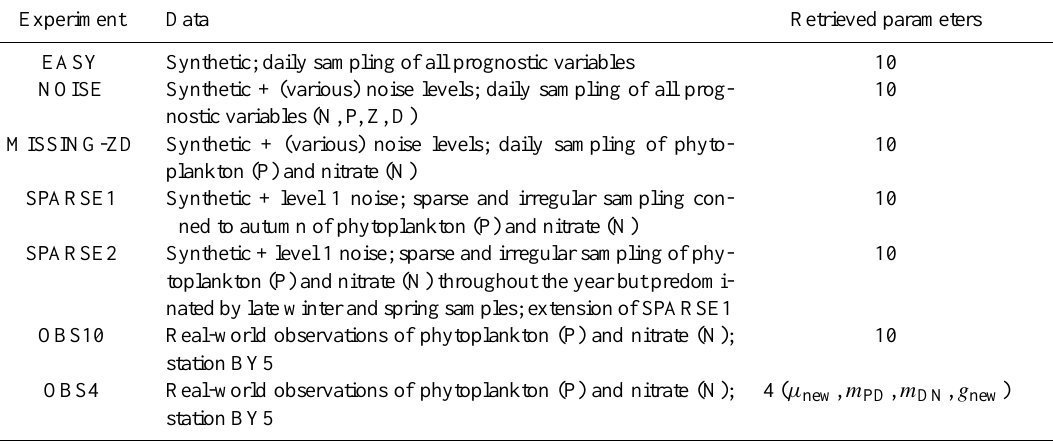
Table 2. Parameter retrieval experiments. The experiments are based on different sets of observations (Sects. 2.4, 2.5) and aim to retrieve all, or a subset of the model parameters listed in Table 1 simultaneously.